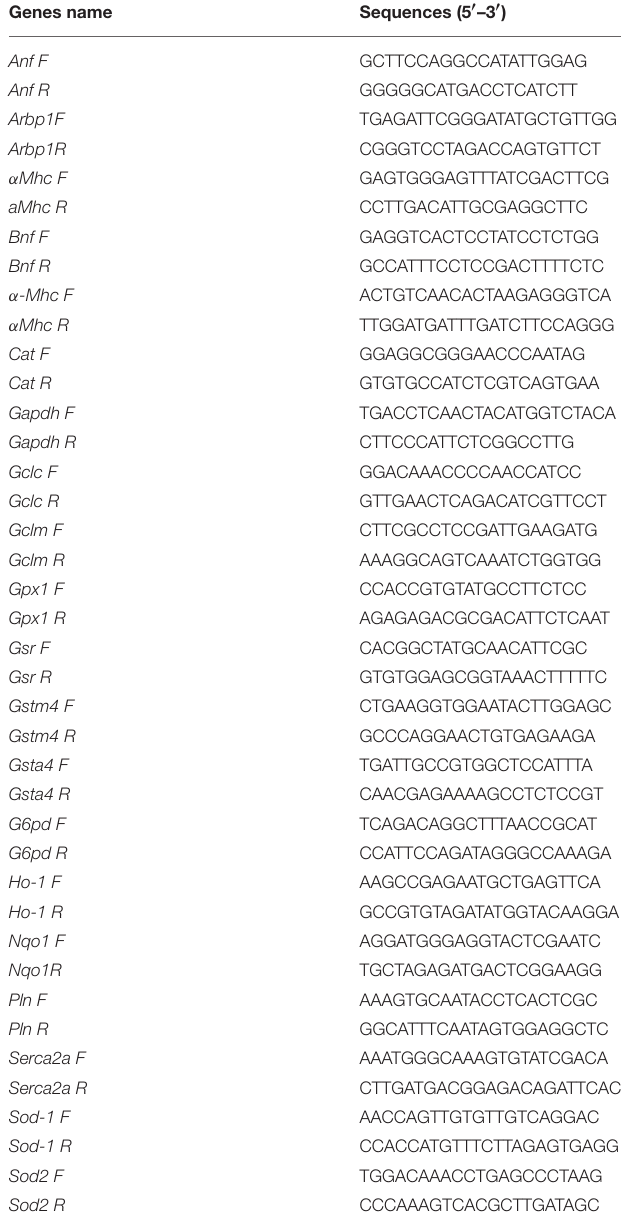
TABLE 1 | List of primers used for qRT-PCR